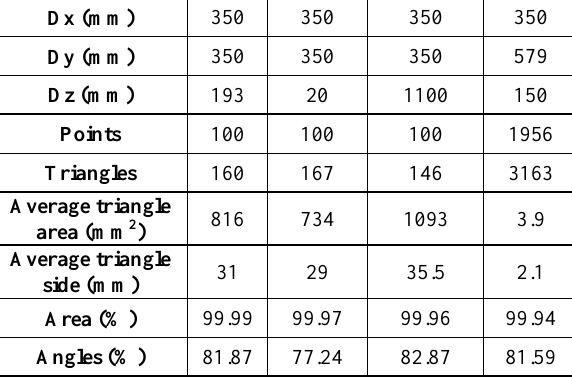
Table 9. Results of the four applications of the